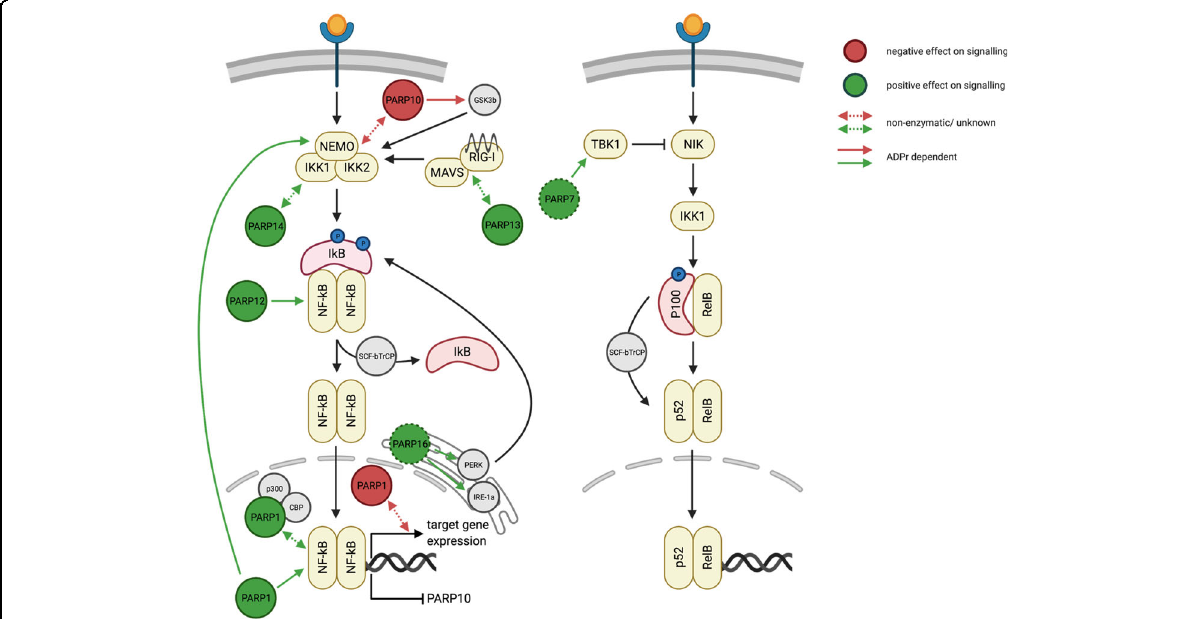
Fig. 1 Schematic overview of the interplay between NF- κ B signaling and ARTD family members. Canonical (left panel) and non-canoncial (right panel) pathway. Positive regulations of NF- κ B signaling by ARTD family members are depicted in green, while negative effects of ARTDs on the signaling pathway are shown in red. Solid lines indicate the contribution of ADP-ribosylation to the regulation of NF- κ B signaling. In case the contribution of ADP-ribosylation was not described or the protein itself rather than its enzymatic activity is involved in the regulation, the interactions are represented by dashed